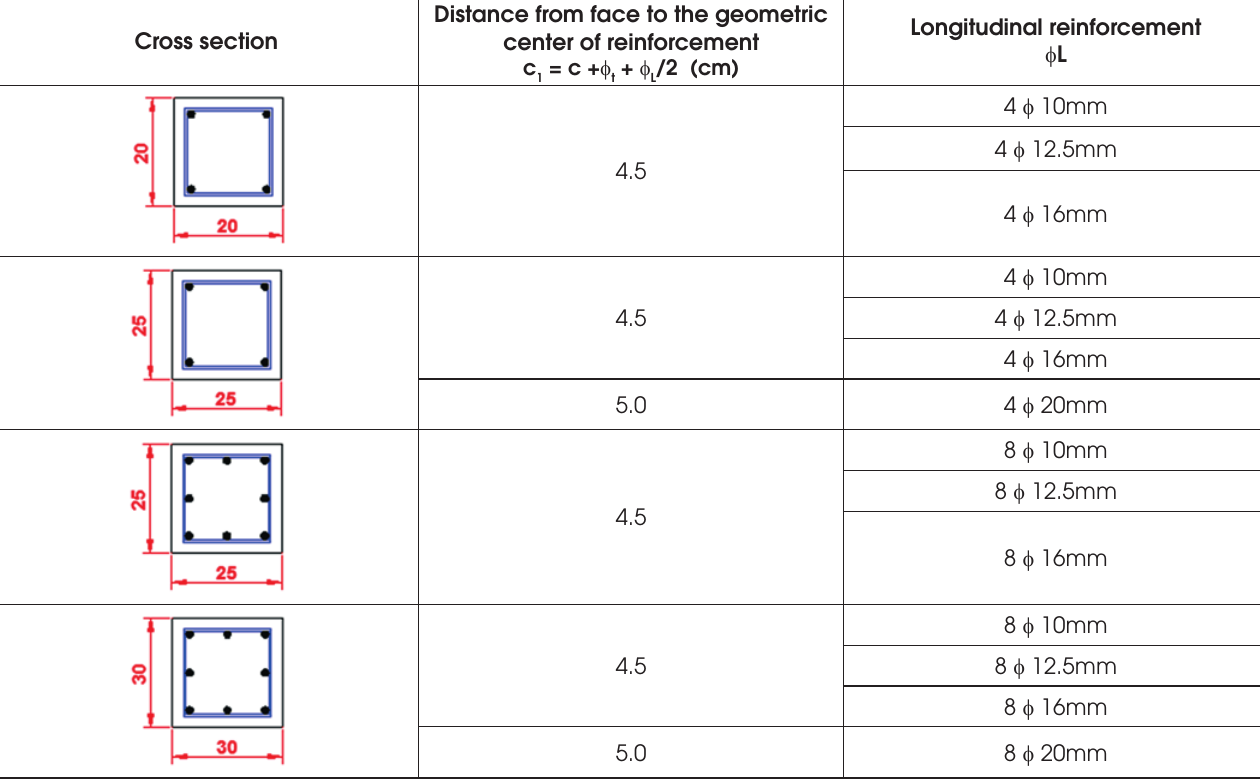
Cross sections studied